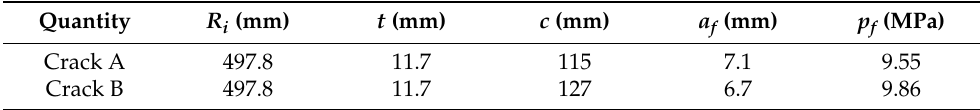
Table 4. Geometric characteristics of the pipes with cracks, crack depth at fracture, and fracture pressure.